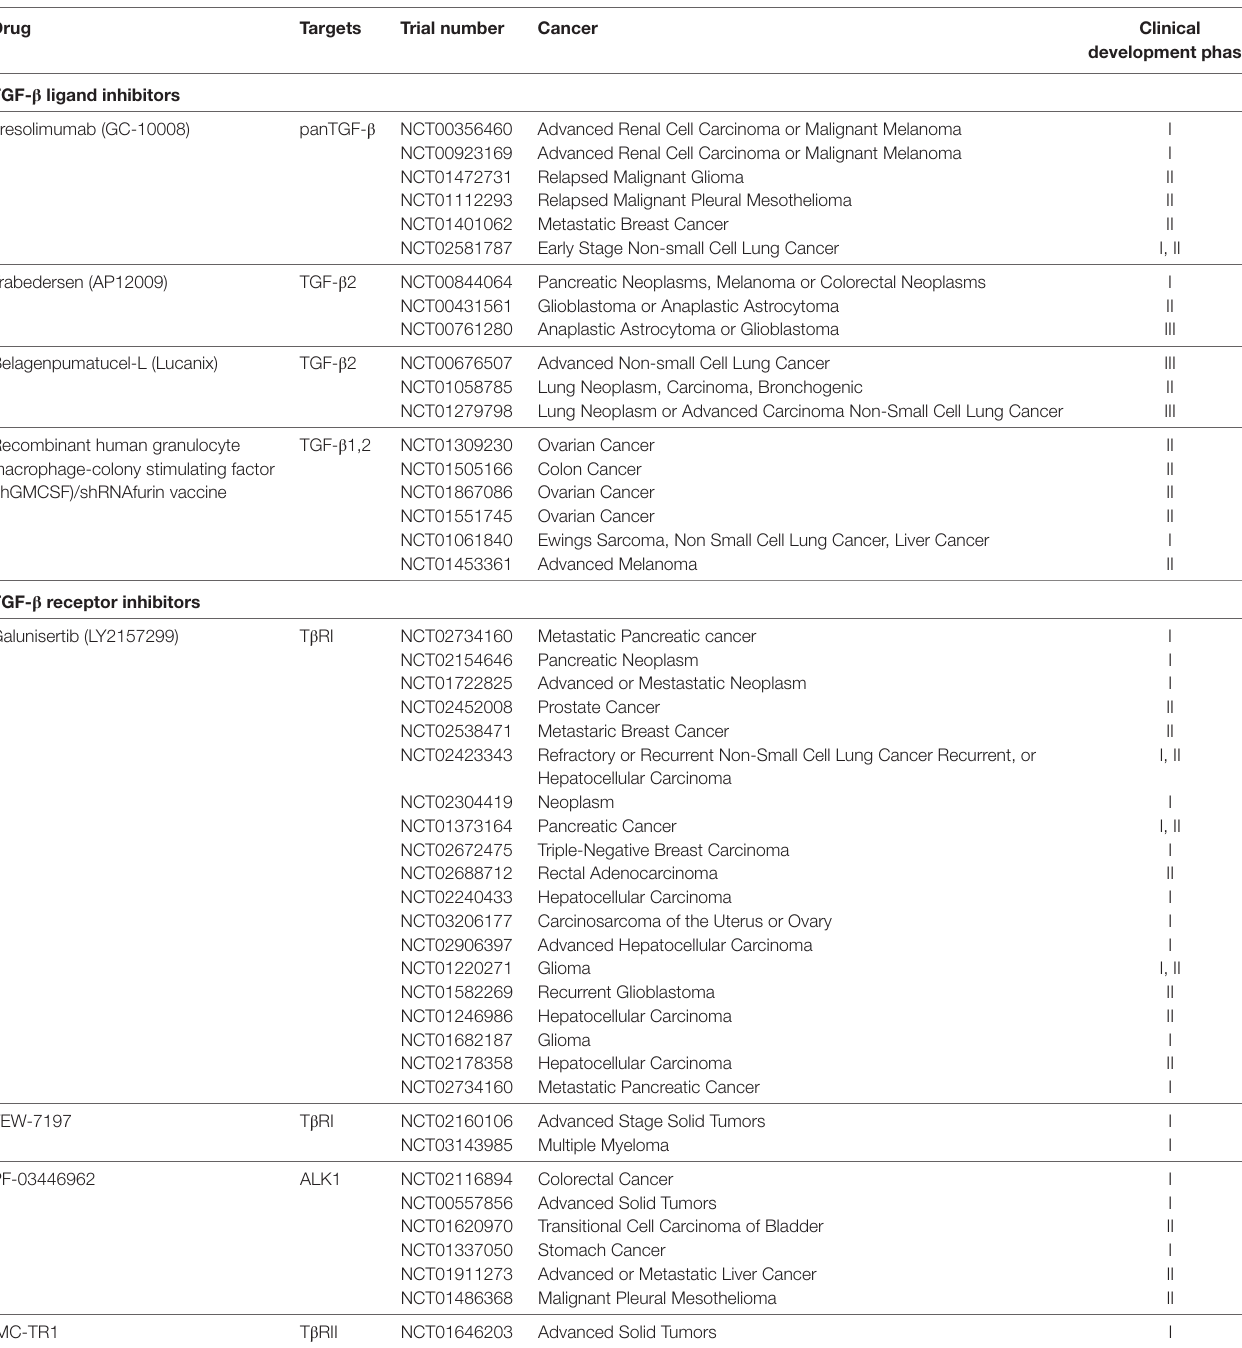
TABLe 1 | Transforming growth factor- β (TGF- β ) inhibitors in clinical development in cancer